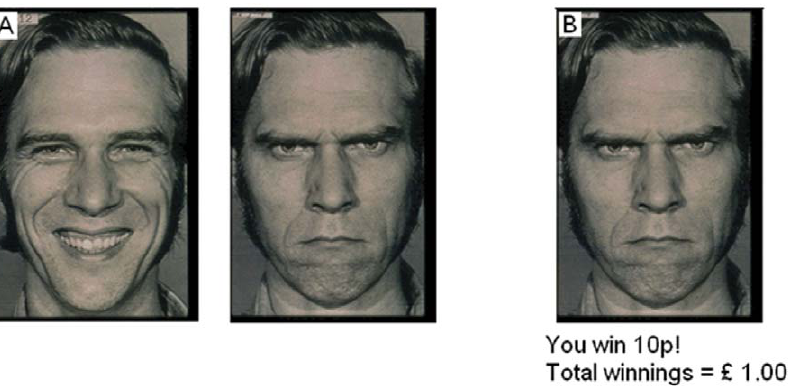
Figure 1. Face task. A: One happy and one angry face were presented side by side on a black screen. B: After a choice (in this case angry face) visual and acoustic feedback was given immediately.